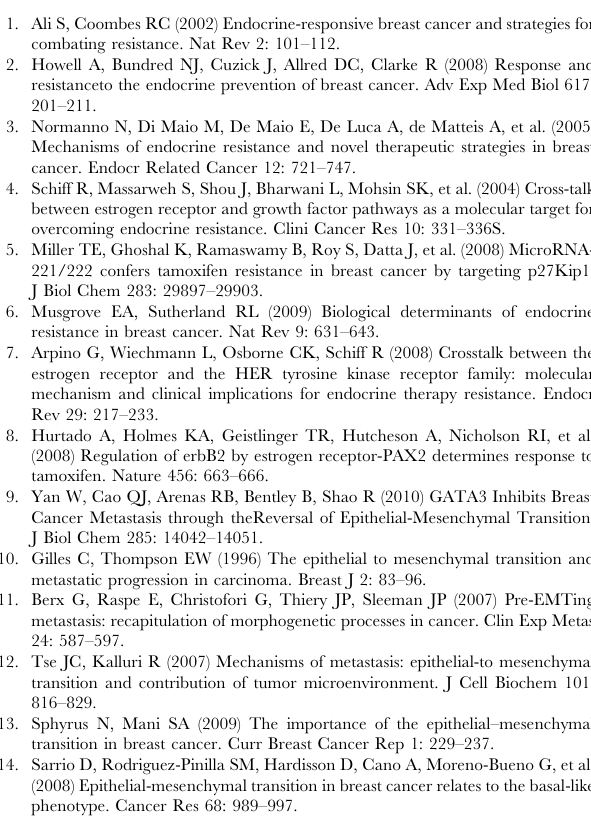
Figure S1 A molecular interaction node depicted by Ingenuity Pathway Analysis centered on molecules involved in cell to cell interaction and subdivided into cellular component/location. The nodal relationships are shown by solid lines indicating direct known interactions and dashed lines for indirect interactions. Additionally, the shape of each node indicates the molecular class. Red nodes indicate